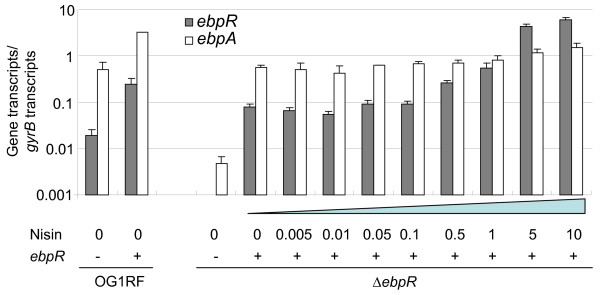
Effect of nisin induction on ebpR and ebpA expression. Cells were grown to an OD600 nm of ~0.8 (3 hr, late log exponential growth phase) and at this point cells were left untreated (0) or treated with increasing concentration of nisin (from 0.005 to 10 ng/ml). Then, cells were collected and RNA extracted. After reverse transcription, ebpA and ebpR cDNA was quantified by real time PCR. The strains were OG1RF or ΔebpR (TX5514) carrying either the empty plasmid (-) or ebpR in trans under the nisin promoter (+). ebpR (gray bars) and ebpA (white bars) transcript levels were normalized with gyrB transcript levels. The data correspond to the mean of two independent experiments.